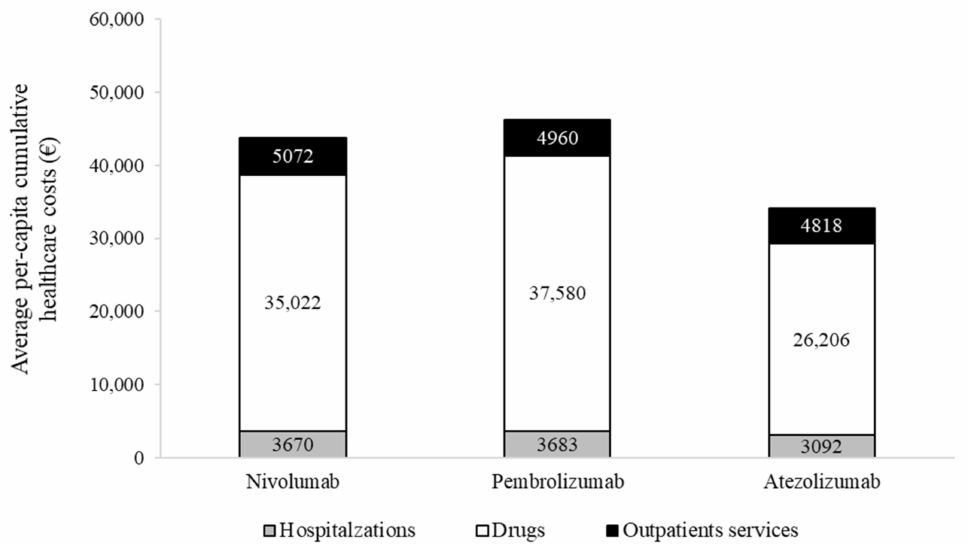
Figure 3. Two-year average per-patient cumulative costs, stratified by second-line systemic treatment.